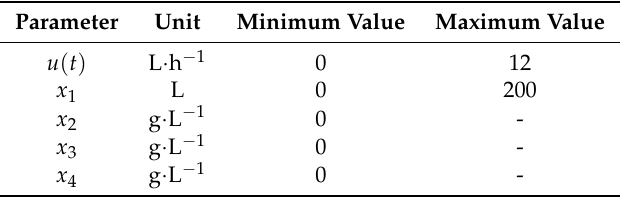
Table 2. Constraints utilized for the resolution of the dynamic optimization